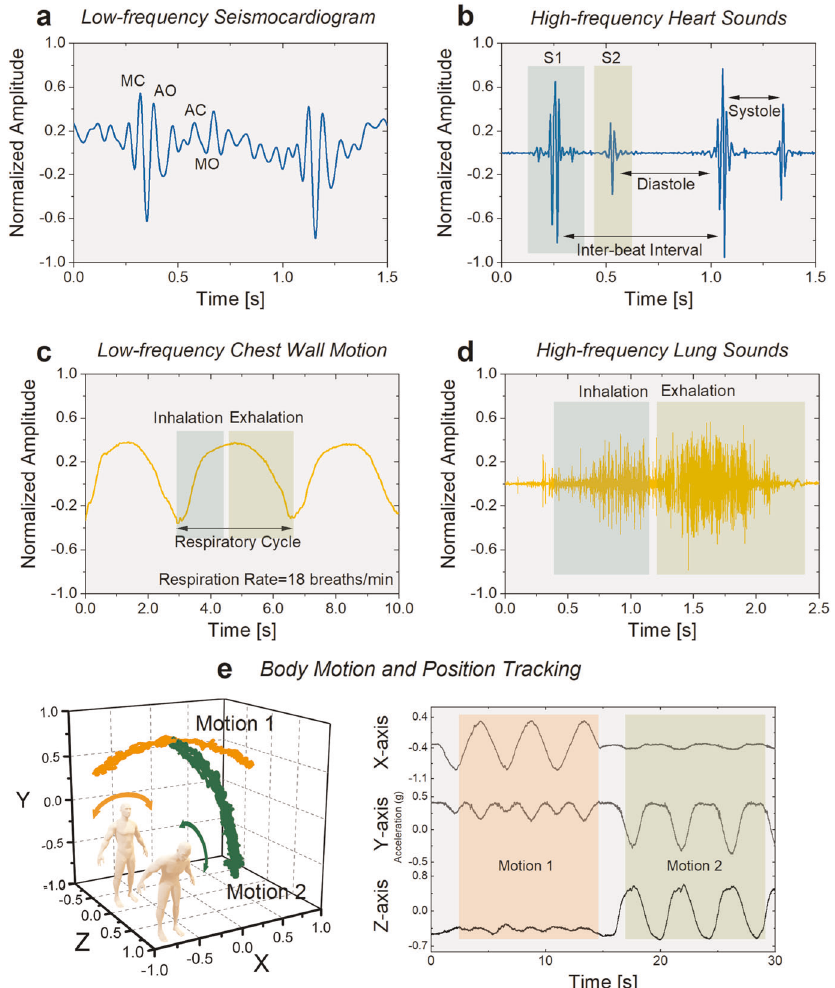
Fig. 2 Recording cardiopulmonary vibrations, sounds and body motion. a Time domain plot of measured SCG signal. Peaks corresponding to occurrence of closing of mitral valve (MC), opening of aortic valve (AO), closing of aortic valve (AC) and opening of mitral valve (MO) are indicated. b Recorded waveforms of two cardiac cycles showcasing sensitivity to the two major cardiac sounds (S 1 and S 2 ). Time intervals of inter-beat, systole and diastole are speci fi ed. c Sensor output signal representing motion of the chest wall during deep-breathing respiratory cycles. Time intervals of inhalation and exhalation are identi fi ed for computation of respiratory rate. d High frequency lung sounds of inhalation and exhalation as recorded by the vibration microsensor. e Body motion tracking in three dimensions, using the ACM along with two in-plane accelerometers, as the individual performs side-to-side (orange) and frontal (green) bending exercises. Time domain plots recorded during exercising showcasing the wide dynamic range of the